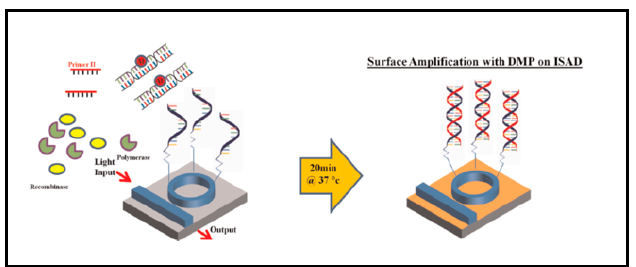
Figure 10. Diagram of HRAS and FGR3 detection study. Surface functionalization on the microring